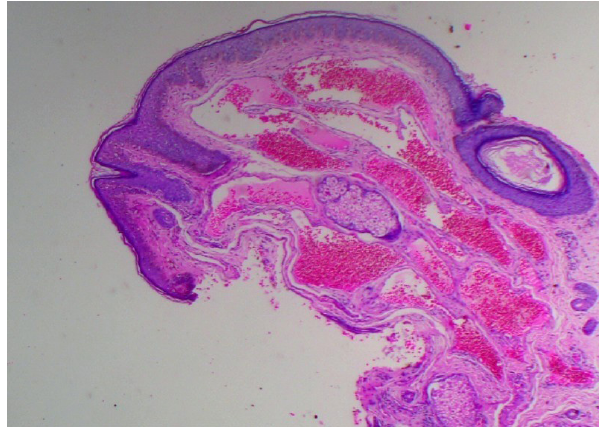
Figure 2: Microphotograph showing a substantial increase in the number of dilated slightly thick-walled capillaries within the papillary and upper reticular dermis. A few capillaries in the superficial and deep plexus were also dilated. A sparse superficial perivascular lymphohistiocytic infiltrate was present. The overlying epidermis was unaffected ( HE stain X